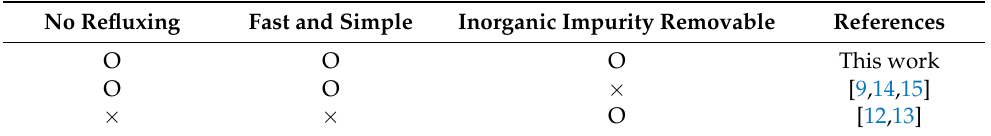
Table 7. Performance improvement by comparison between the method proposed in this study and other extraction methods from references. O and × represent yes and no,